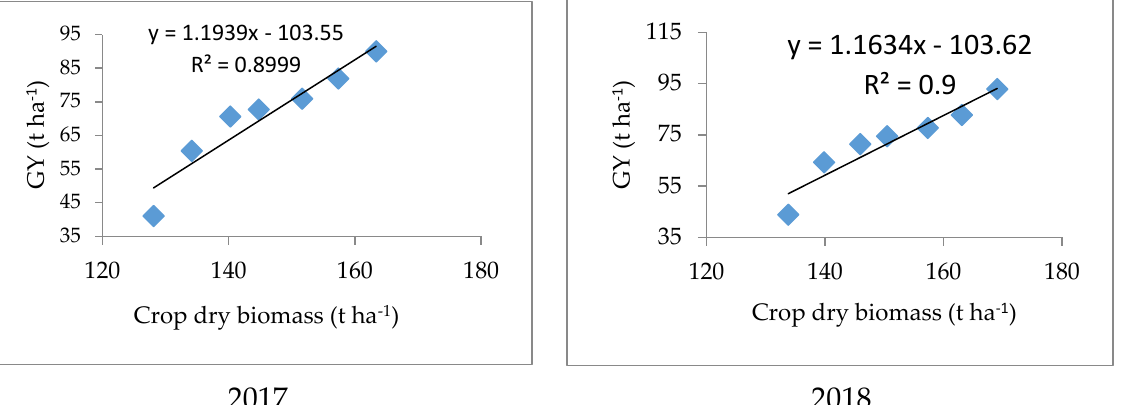
Figure 6. Linear regression line among crop establishment methods between N uptake vs. Grain yield (GY).